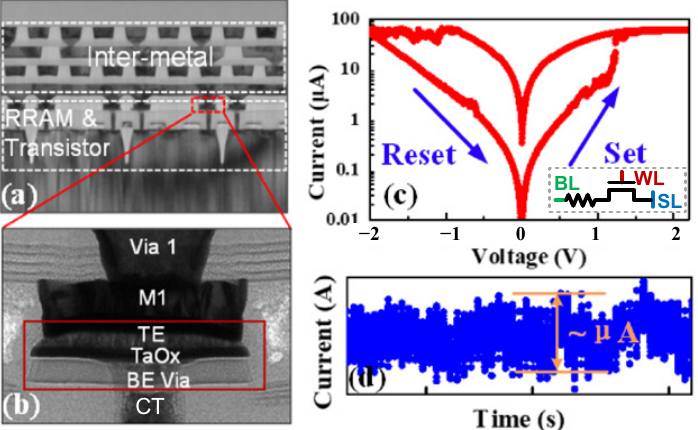
Figure 2. Structure and characteristics of RRAM. ( a ) The cross-section of RRAM cell in a 28 nm process 1T1R array. The RRAM unit is built between contact and Metal 1; ( b ) the magnified view of the cell structure; ( c ) typical DC I-V characteristics of the RRAM cell and structure of 1T1R RRAM; ( d ) the noise measured in the 28 nm RRAM cell; the array size is 16 Kb.